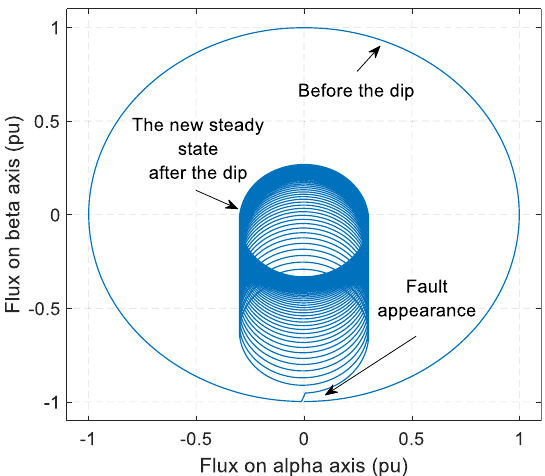
Fig. 5 Stator flux phasor trajectory in a fixed ( αβ ) reference frame during a